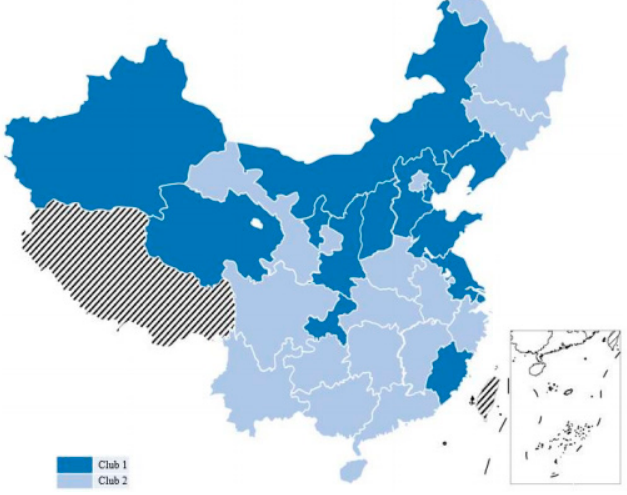
Figure 2. Results of the club grouping. Table 4. Grouping of clubs.